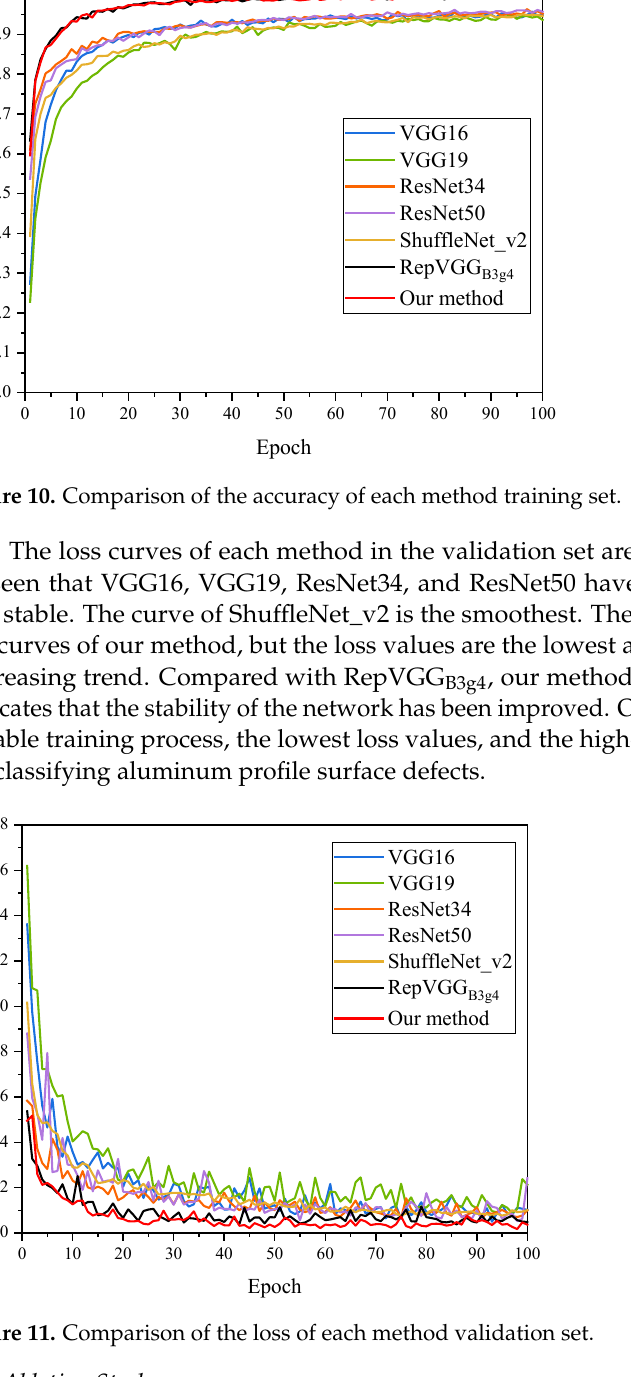
Figure 11. Comparison of the loss of each method validation set.